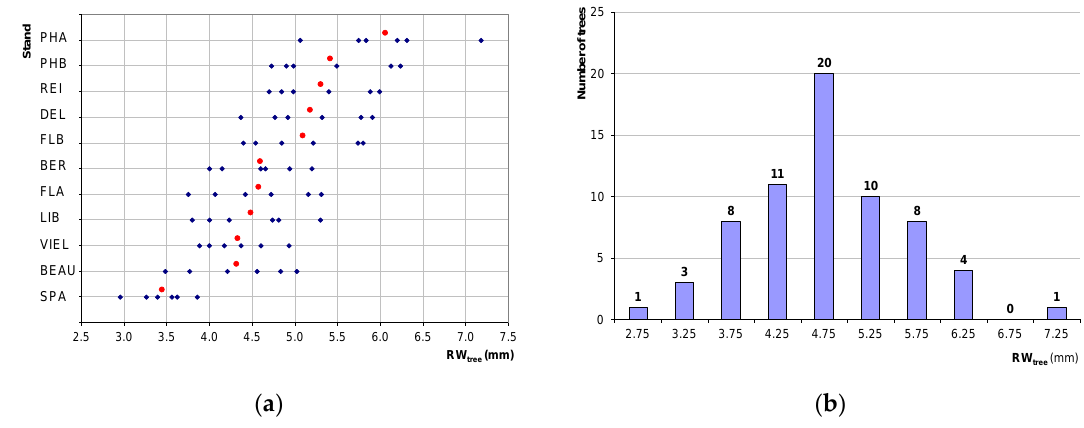
Figure 1. ( a ) Mean ring widths of the 66 trees (RW tree —squares), measured at 2 m height. For each of the 11 stands, an average RW tree was calculated (circles) on the basis of the six individual values; ( b ) Frequency distribution of RW tree in classes of 0.5 mm, from [2.5 mm; 3.0 mm] to [7.0 mm; 7.5 mm].